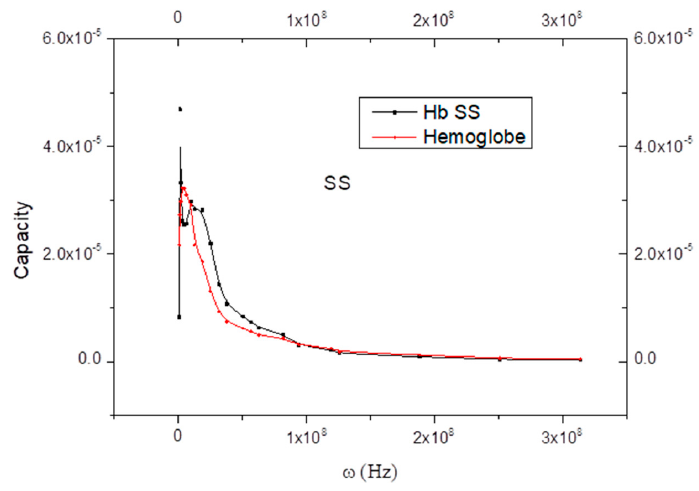
Figure 4. Comparison between HbSS (black line) and Hemoglobe (red line) capacity expressed in p-Farad (pF) calculated by Equations (30) and (31), respectively, as a function of frequency.